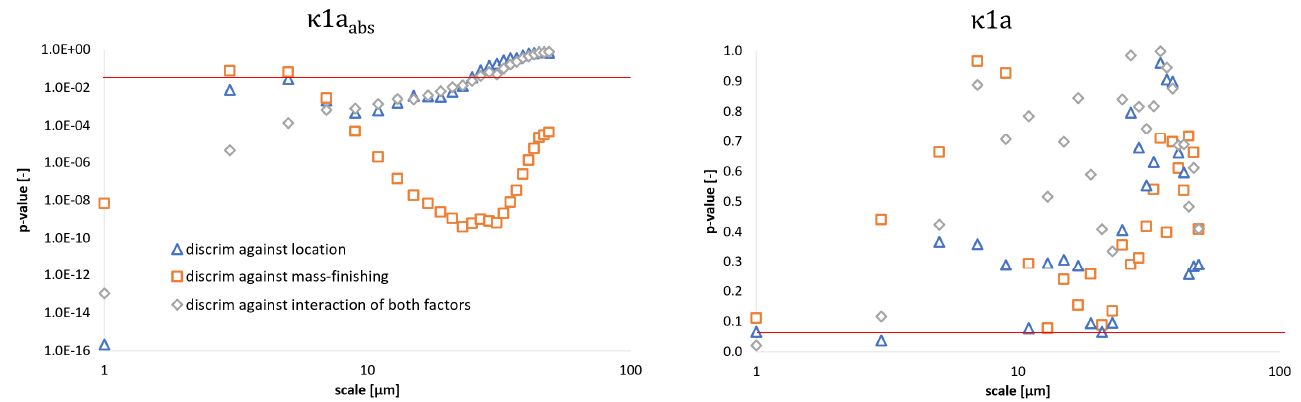
Figure 12. Evolution of p -value calculated in the discrimination analysis of two independent formation factors and their product as a function of scale for average absolute maximum curvature ( left ) and their signed counterpart ( right ). Please note that the red line indicates p = 0.05 at each graph.